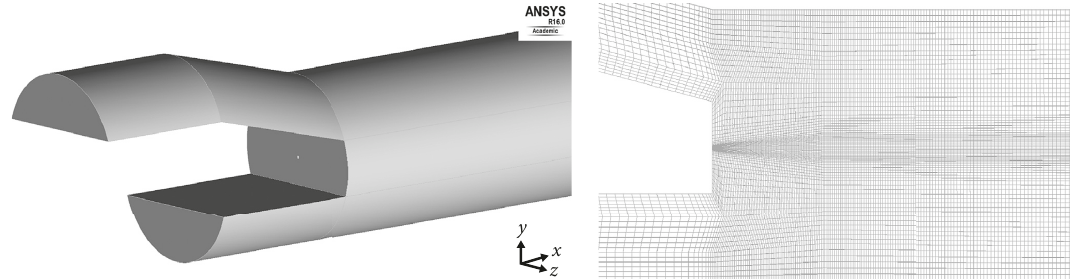
Figure 1: Geometry (part) of the down-scaled, simplified kiln model in Cartesian coordinate system and the hexagonal mesh (fine grid) with refinement near the jet inlet with multiple